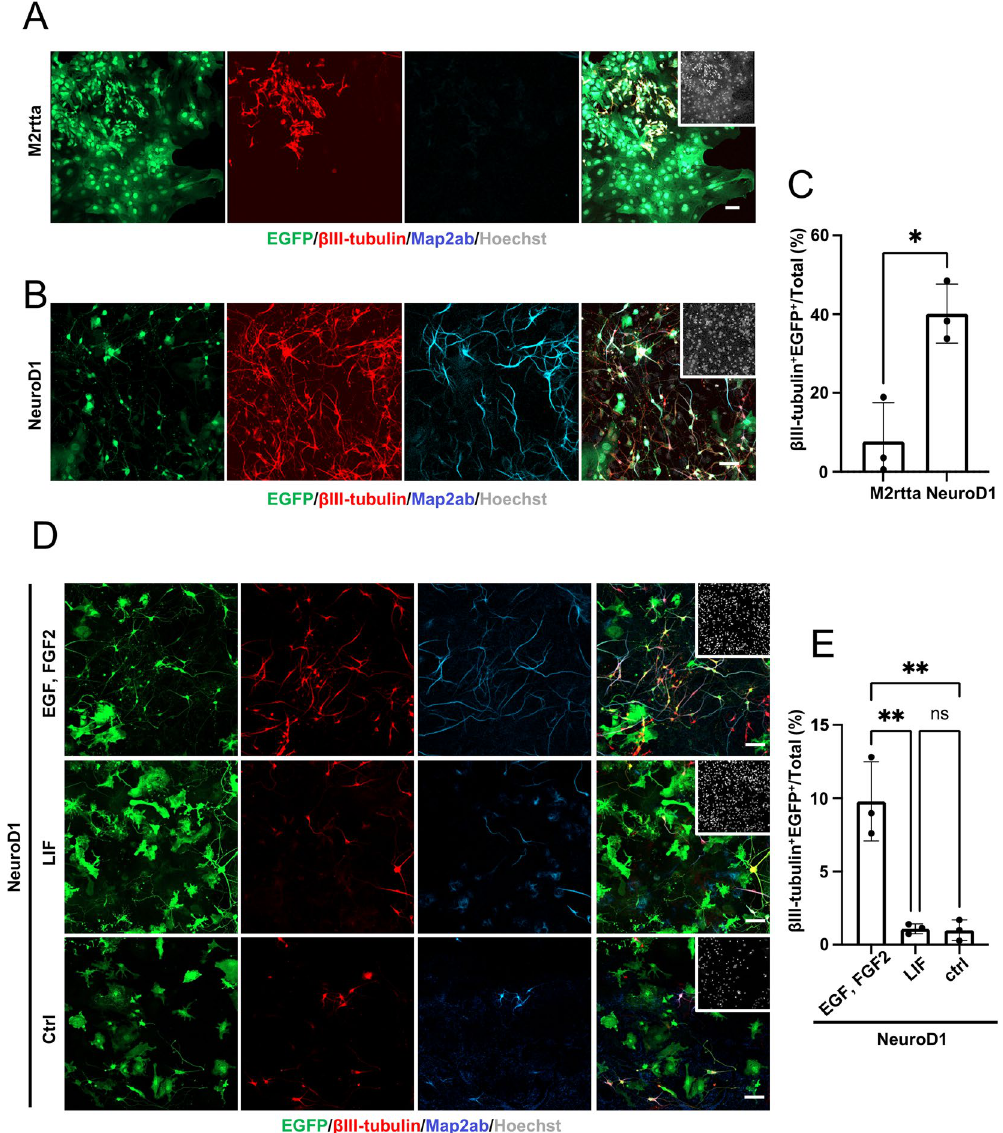
Figure 3. Environmental stimulation affects neuronal reprogramming efficiency. ( A ) Representative images of staining for EGFP (green), βIII-tubulin (red), and Map2ab (cyan) at 7 dpt of astrocytes infected with two viruses (EGFP- and M2rtta-viruses; indicated as M2rtta) and culturing with EGF and FGF2. Dox, 1 μg/mL. Scale bar, 100 μm. ( B ) Representative images of staining for EGFP (green), βIII-tubulin (red), and Map2ab (cyan) at 7 dpt of astrocytes infected with three viruses (EGFP-, M2rtta-, and NeuroD1-viruses; indicated as NeuroD1) and culturing with EGF and FGF2. Dox, 1 μg/mL. Scale bar, 100 μm. ( C ) Quantification of the βIII-tubulin and EGFP + cells in ( A and B ) (n = 3). * p < 0.05 by unpaired Student’s t test. ( D ) Representative images of staining for EGFP (green), βIII-tubulin (red), and Map2ab (cyan) in NeuroD1-transduced NR-astrocytes cultured with EGF and FGF2, LIF, and without these factors (Ctrl) at 7 dpt. EGF and FGF2 or LIF were applied for 3 days. Dox, 1 μg/mL. Scale bars, 100 μm. ( E ) Quantification of the βIII-tubulin and EGFP + cells in ( D ) (n = 3). ** p < 0.005 by ANOVA with Tukey post hoc tests. ns means not significant ( p >